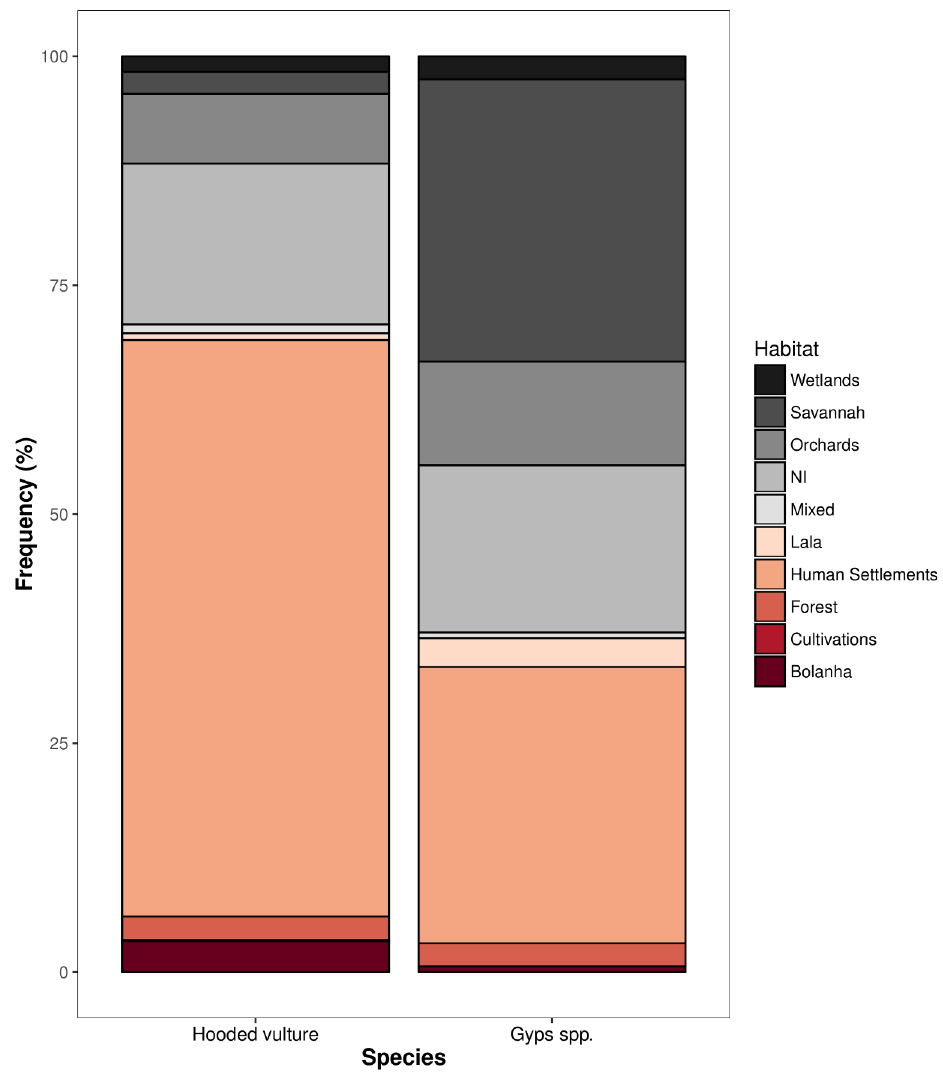
Fig 4. Distribution over habitats of most abundant vulture species. Distribution over habitats of most abundant vulture species during transect surveys in Guinea-Bissau mainland. (NI–Non-identified habitat). Gyps spp . consist mostly of African white-backed